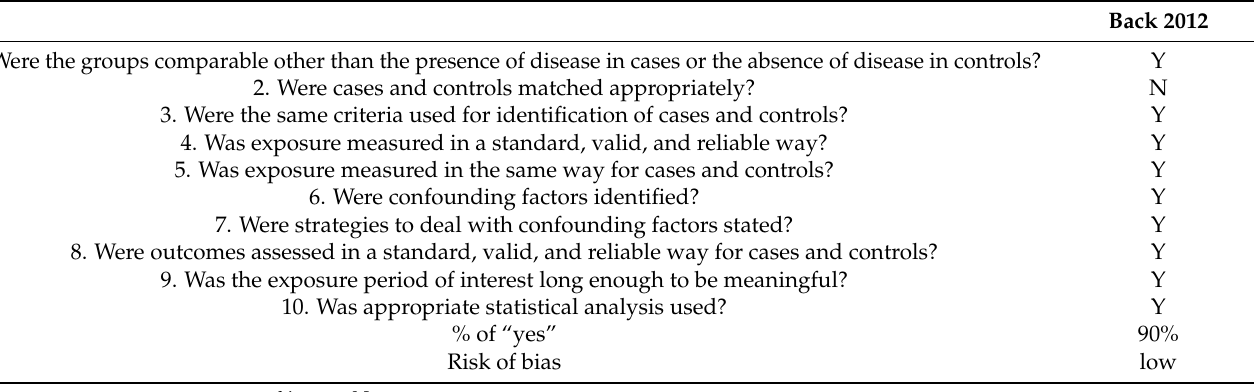
Table 5. JBI Critical Appraisal Checklist for Case–Control Studies.